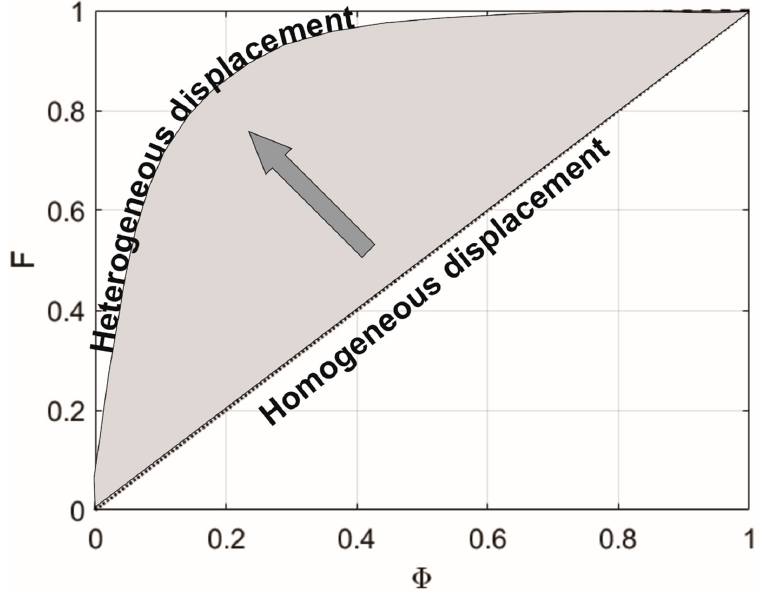
Figure 1. Graphical interpretation of the Lorenz coefficient, in the Grey shaded area, as twice the net difference between the integrals of the non-ideal and ideal F ( Φ ) curves for solute front displacement. The arrow direction indicates the designs with a pronounced adverse effect of the physical heterogeneity.